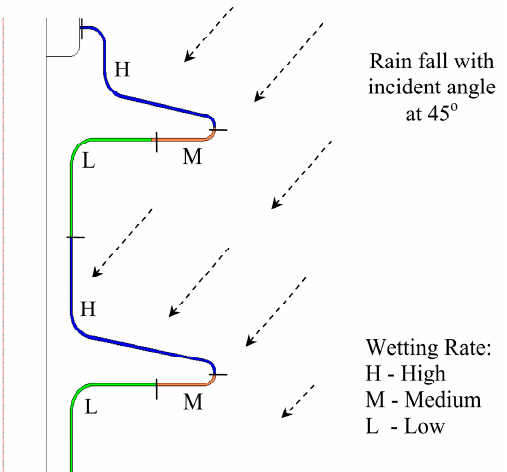
Figure 3. Subdivision of pollution layer under light rain